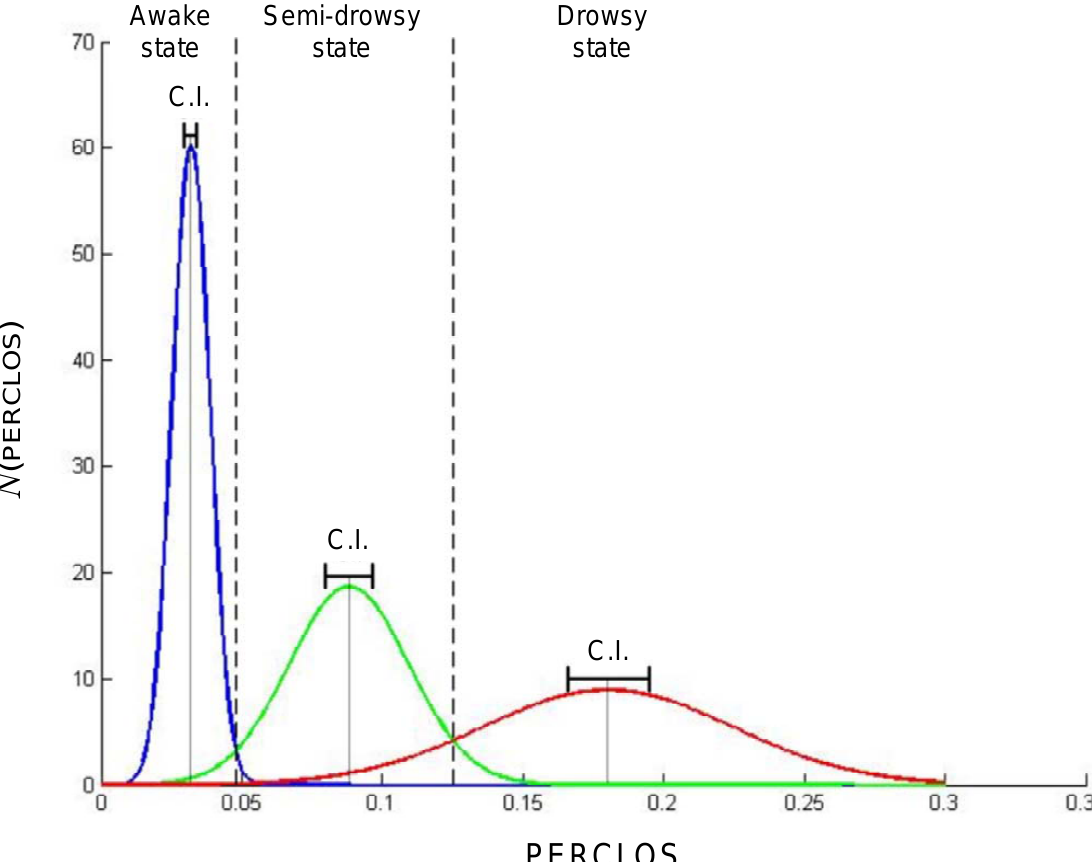
Figure 1. Normal distributions of the different states of alert calculated for the awake, semi-drowsy and drowsy subjects, showing the means, the confidence intervals (CI) and the identification threshold between one level of alertness and the other. Awake